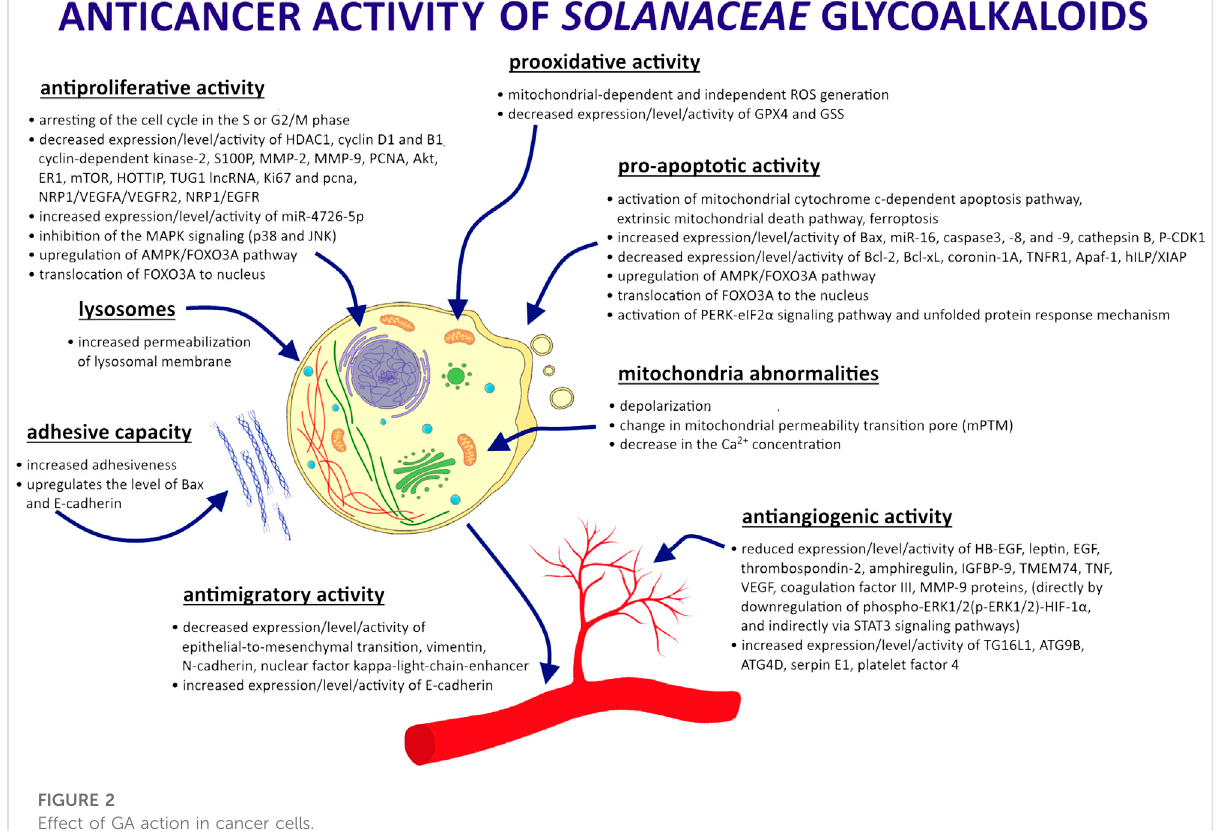
FIGURE 2 Effect of GA action in cancer